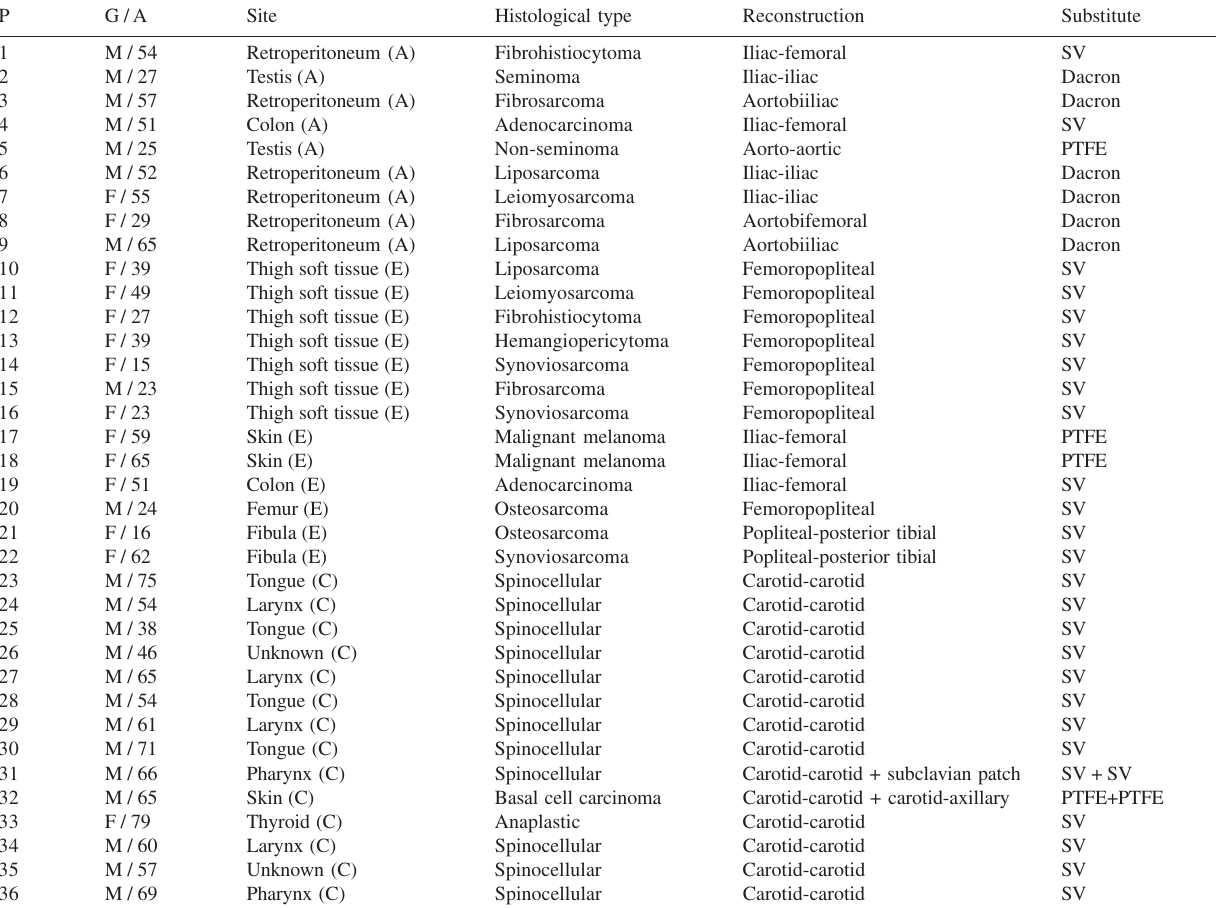
Table 1 - Clinical characteristics, tumor location, histological type, vascular reconstruction, and vascular